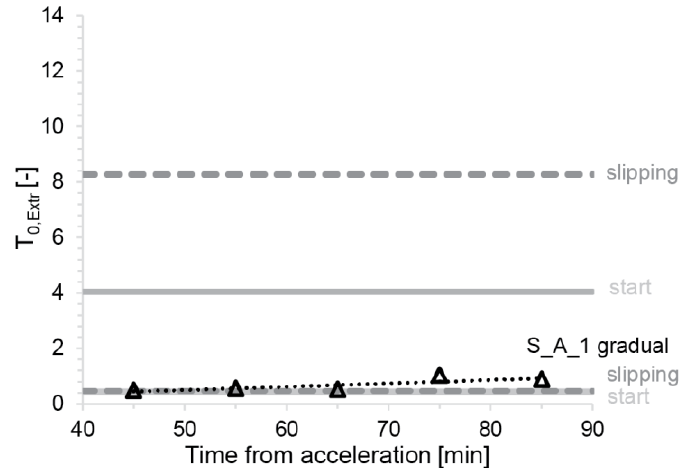
Figure A5. The process window expressed with the dimensionless yield stress for the start of slipping